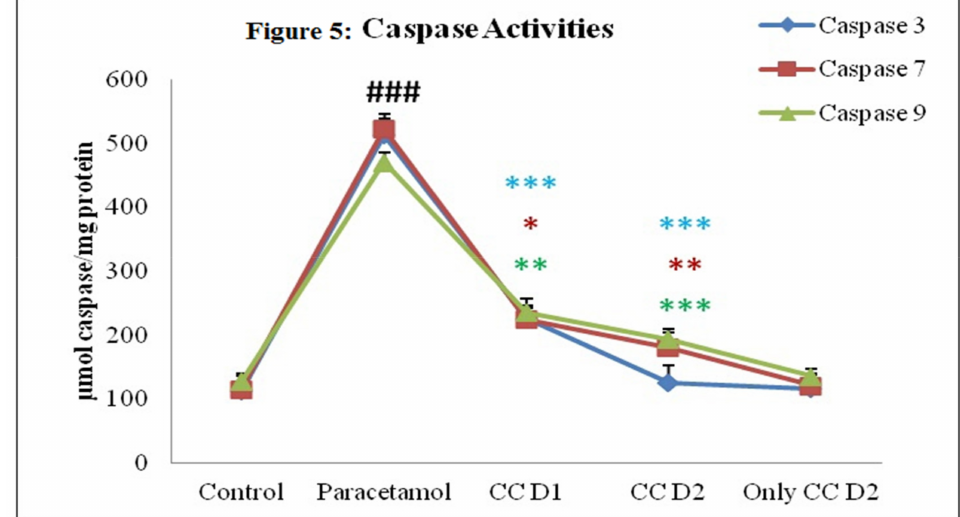
Figure 5. Effect on acetaminophen-induced caspase activities by Carum carvi treatment. Represen- tative graph of Carum carvi effect with respect to acetaminophen-induced toxicity on caspases 3, 7, and 9. The mean ± SE (n = 6) is denoted by each value. ### p < 0.001 compared to control group. *** p < 0.001, ** p < 0.01, and * p < 0.05 compared to acetaminophen-treated group. D1 and D2: doses of 100 and 200 mg/kg body weight of Carum carvi ,